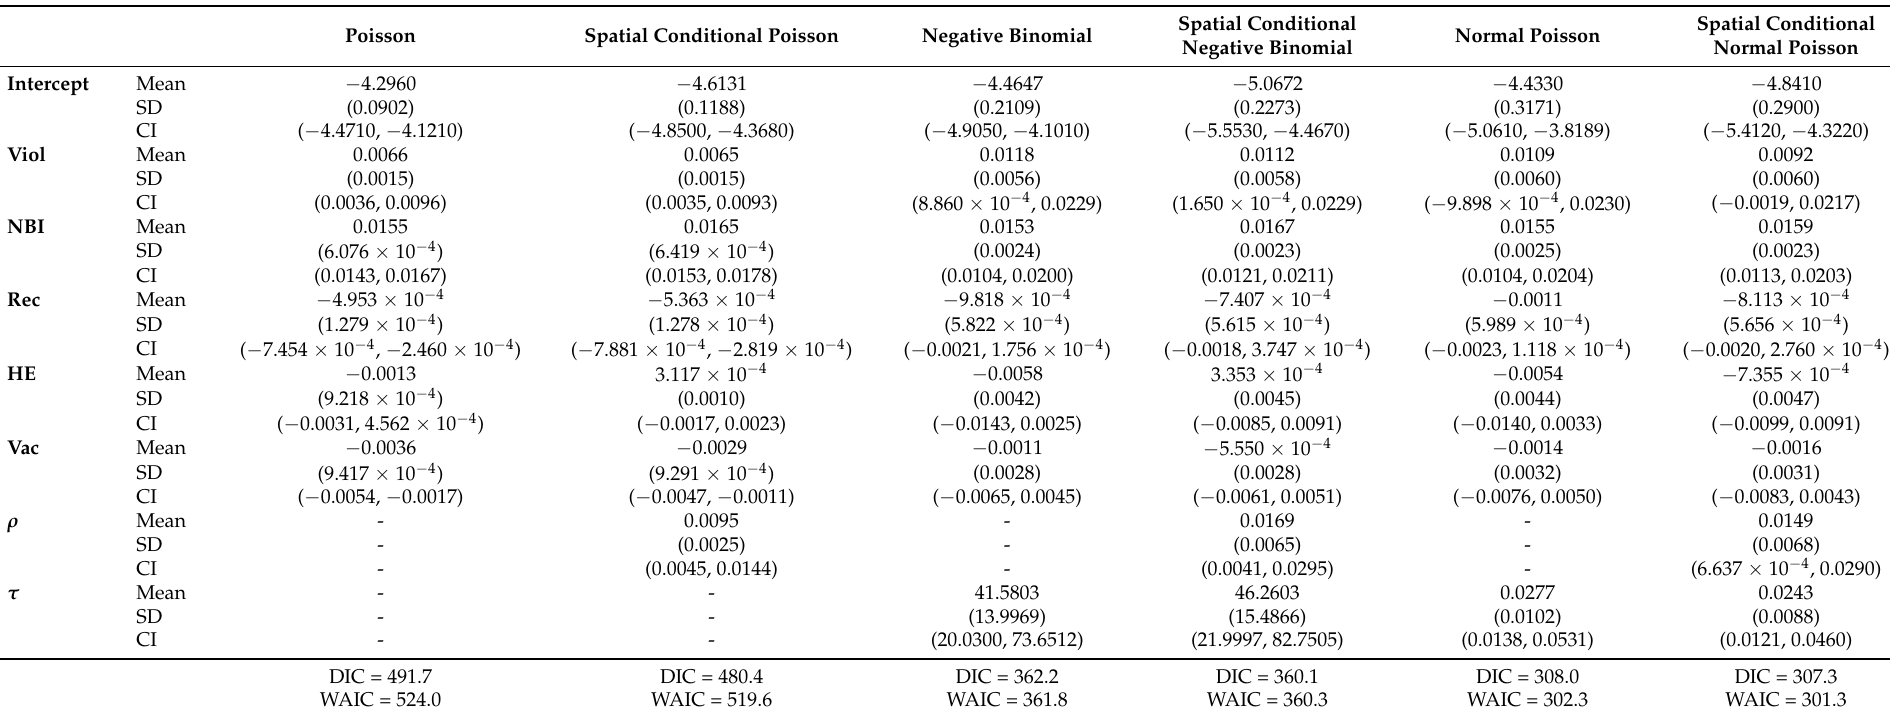
Table 2. Parameter estimates, standard deviations and 95% credible intervals in parenthesis for the parameters in the models, and DIC and WAIC values for the different models fitted to the Colombian infant mortality rates data